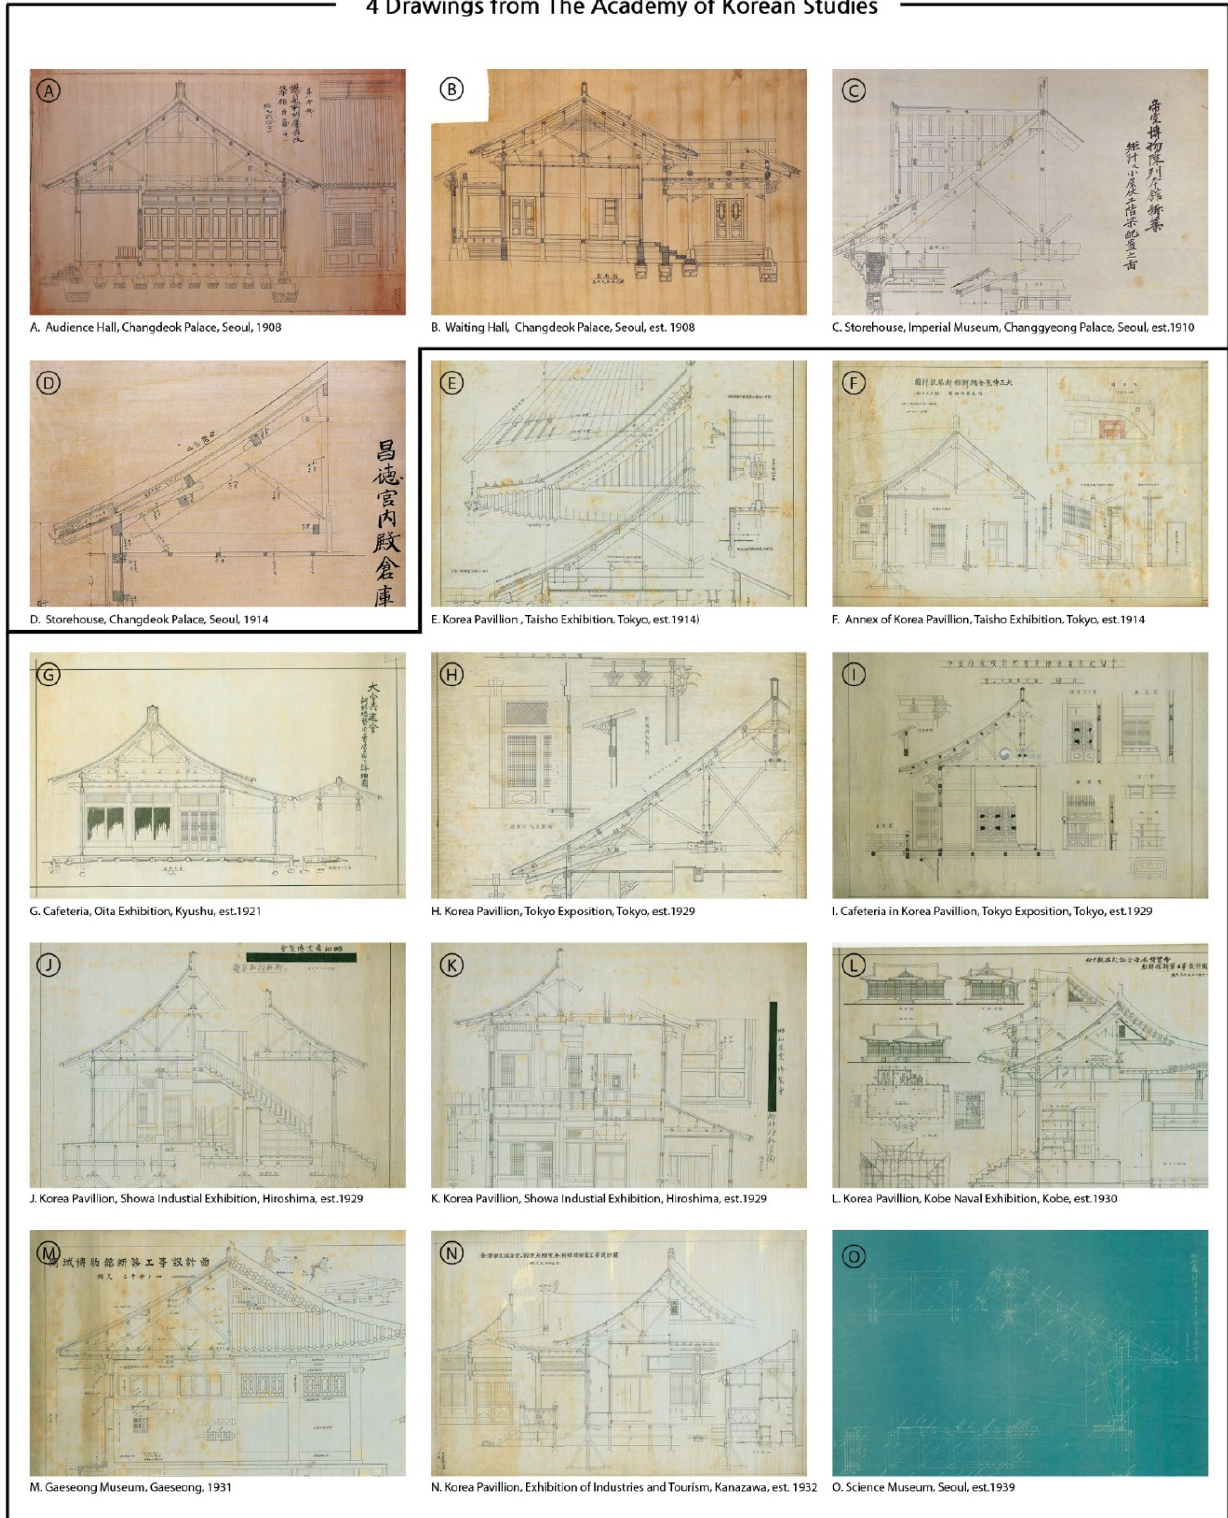
Figure 6. 15 Cases of ‘Hybridized Roofs’ That Had a Korean-Style Roof Form, Applied a Western Truss, and Was Designed by the Japanese: 4 Drawings from the Academy of Korean Studies, and 11 Drawings from the National Archives of Korea.